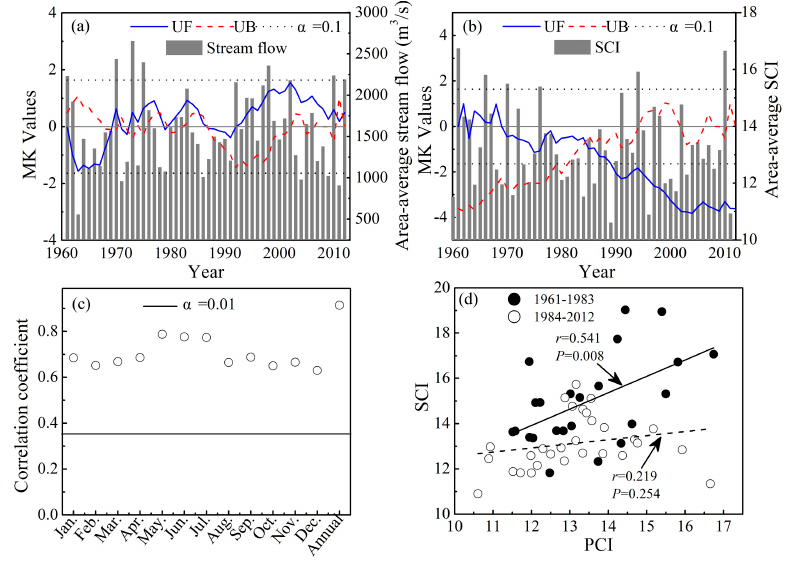
Figure 7. Area ‐ average stream flow ( a ); area ‐ average SCI series ( b ); Pearson’s correlation coefficient between area ‐ averaged stream flow and precipitation ( c ); and correlation coefficient between area ‐ average SCI and PCI in different periods ( d ).